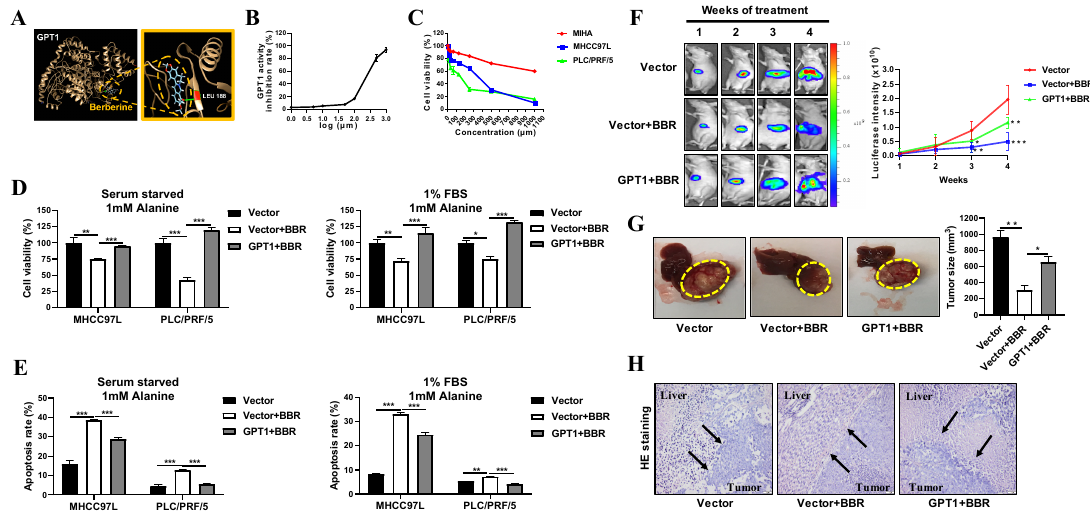
Figure 4. Targeting GPT1 by a small molecule BBR (berberine) suppressed HCC growth. ( A ) The